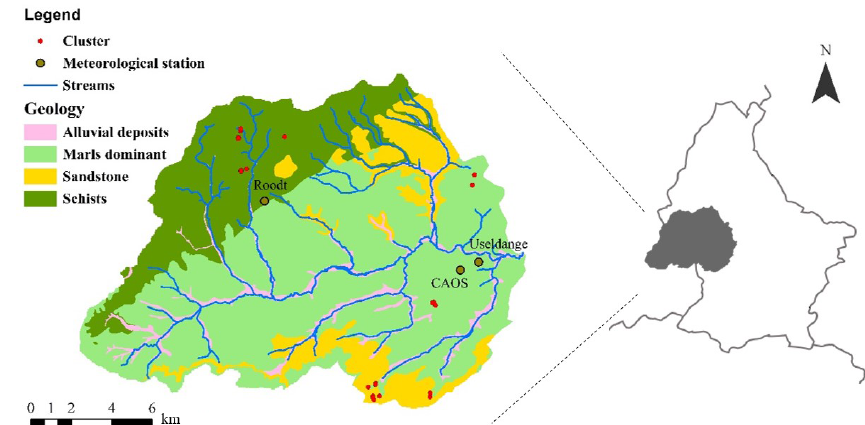
Figure 1. The geology of the Attert catchment and its location in Luxembourg. Sandstone in the catchment is a combination of Buntsandstein sandstone in the north and Lower Jurassic sandstone in the south. Also shown are the main streams, sensor clusters, meteorological stations Roodt and Useldange, and the location of the CAOS sensor cluster where wind speed and relative humidity measurements were taken from.